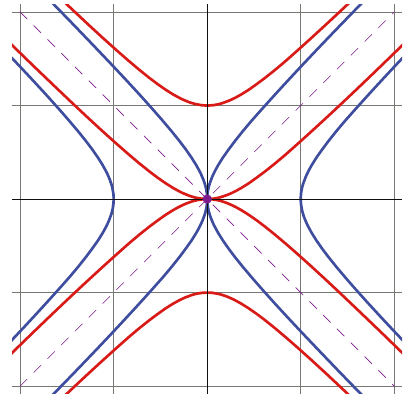
Figure 2: Spacelike ( blue ) and timelike ( red ) pseudocircle with (cid:2) ( )